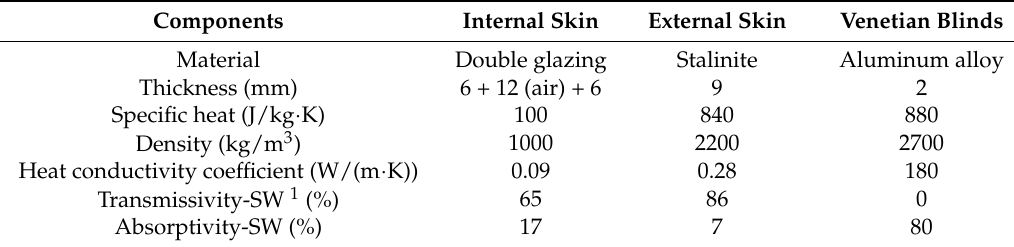
Figure 3. Structures and dimensions of the simulated envelope: ( a ) Pipe-embedded window; and ( b ) Pipe-embedded wall. Table 1. Physical parameters of the window materials.